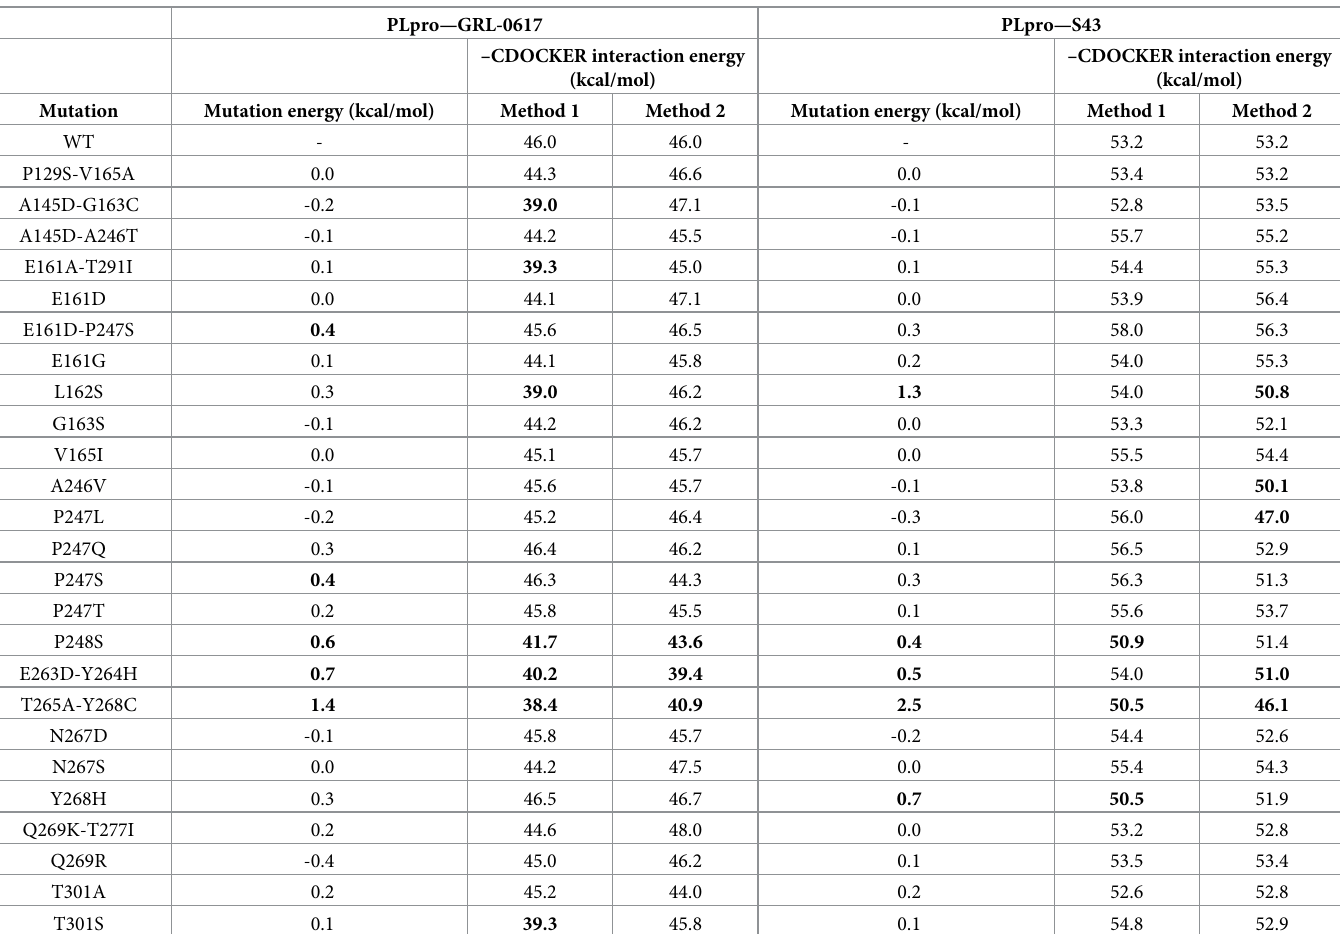
Table 2. Results of the estimated impact of the mutations at the PLpro binding site on the inhibitor binding. For each PLpro-inhibitor complex, the first column shows mutation energy, which is the difference of the binding energies between the respective mutant and the wild type (WT) protein, estimated using Calculate Binding Energies protocol in Discovery Studio. The next two columns include negatives of the CDOCKER interaction energies from molecular docking conducted to the PLpro mutants prepared with two methods in Discovery Studio. The first one utilized the Build Mutant protocol. The second one consisted of the mutation of specific residues with a subsequent side chain conformation